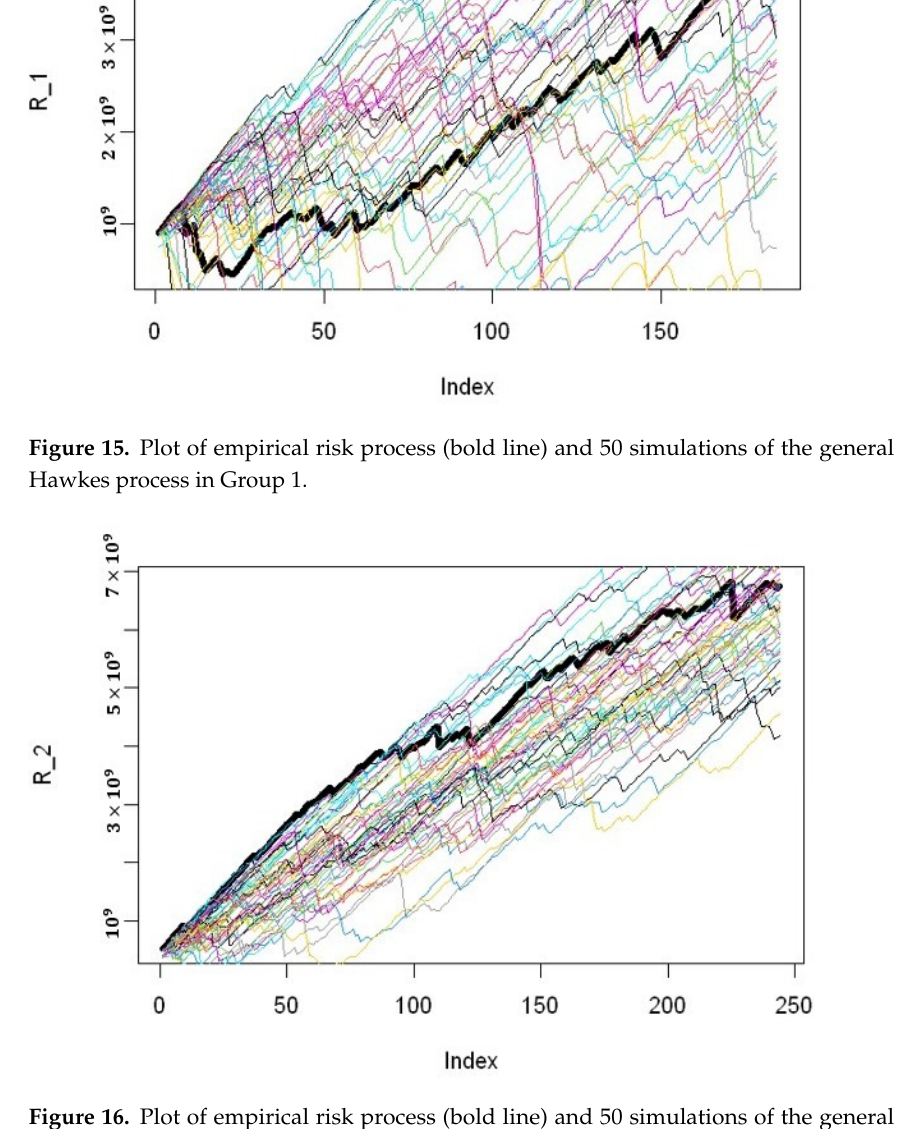
Figure 16. Plot of empirical risk process (bold line) and 50 simulations of the general compound Hawkes process in Group